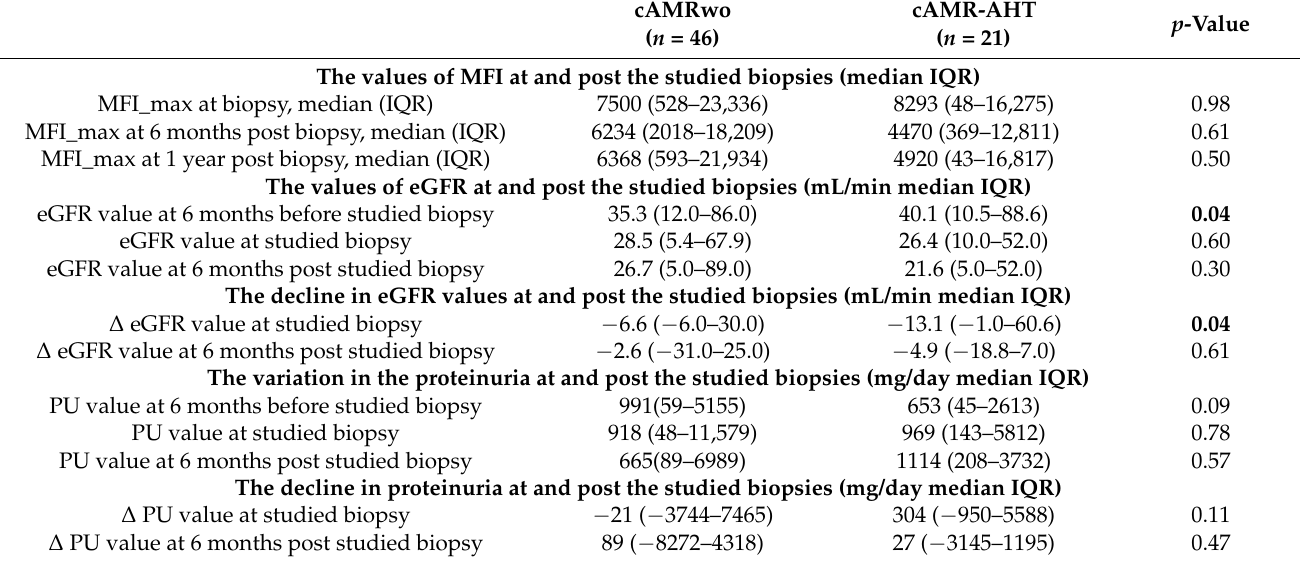
Comparison of DSA, estimated glomerular filtration rate (eGFR) and proteinuria between